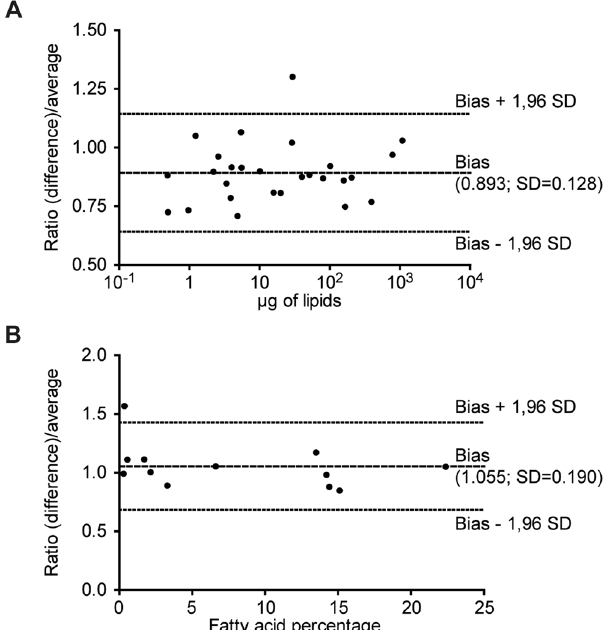
Figure 4. Comparison of methods by Bland-Altman analysis. Bland-Altman plots with mean bias (central line) and 95% limits of agreement (outer lines) for results found after dual extraction and by the reference method (Bligh and Dyer; Figs 2 and 3). ( A ) The analyses were performed for neutral lipid analyses and ( B ) analyses of fatty acid composition. s.d.: standard